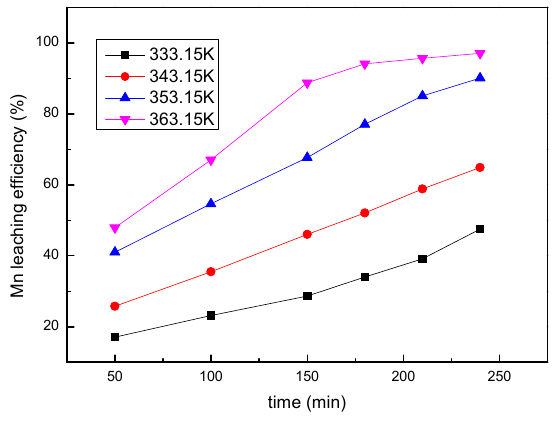
Figure 6. The effect of the temperature on the manganese leaching efficiency.